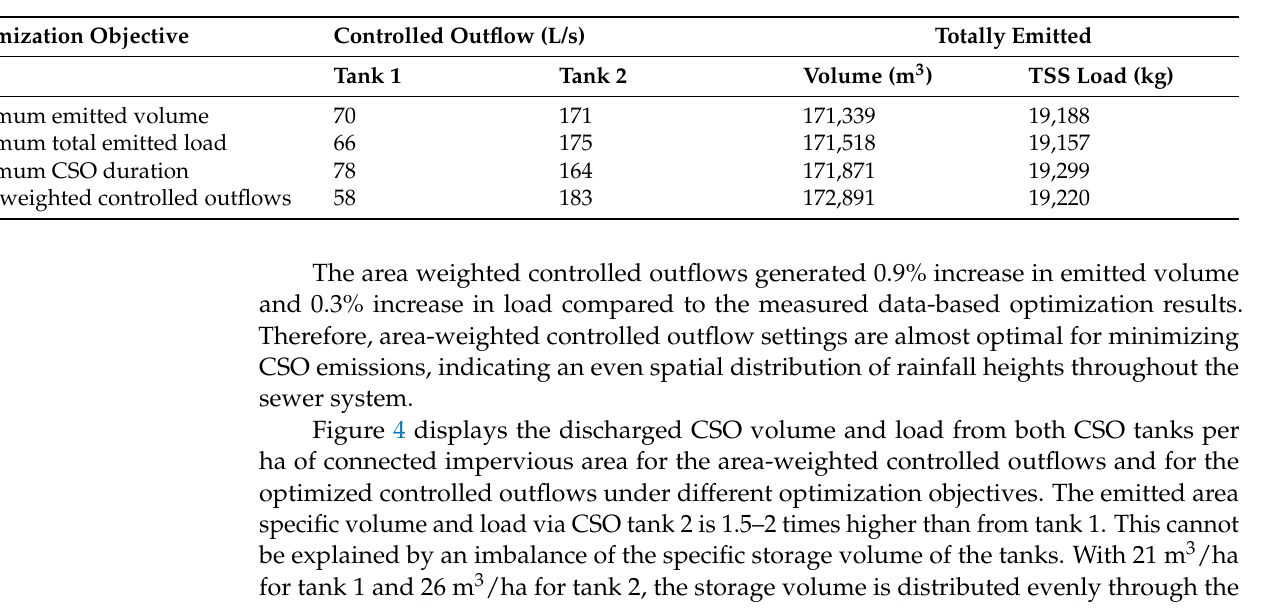
Table 2. Optimized controlled outflows and resulting total emitted loads and volumes for different optimization objectives and area-weighted controlled outflows.